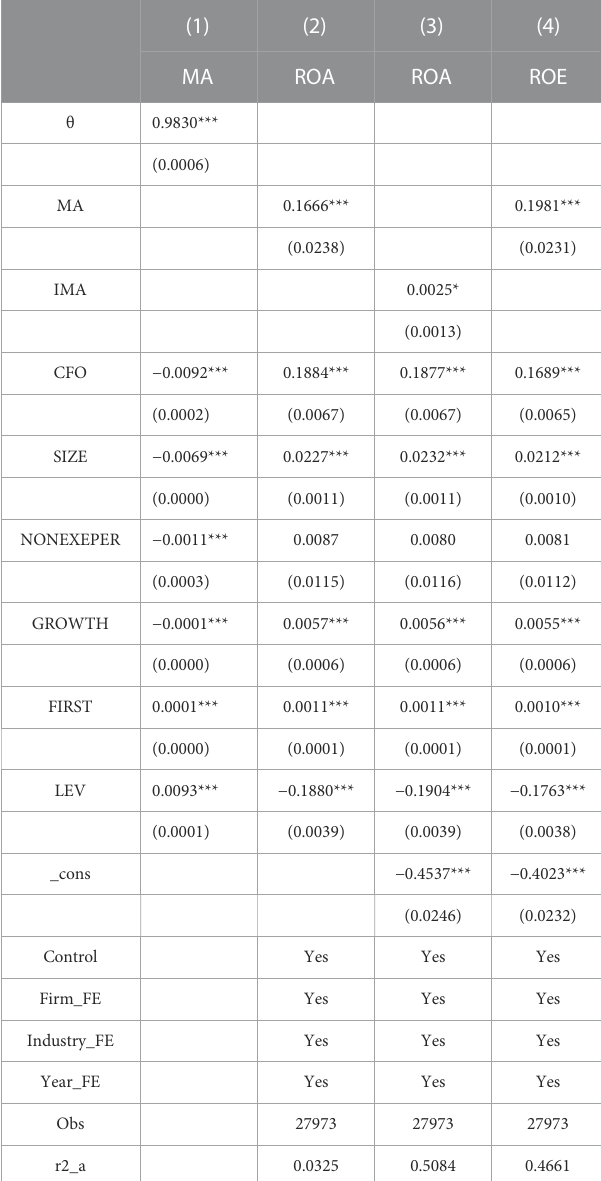
TABLE 3 Robustness test